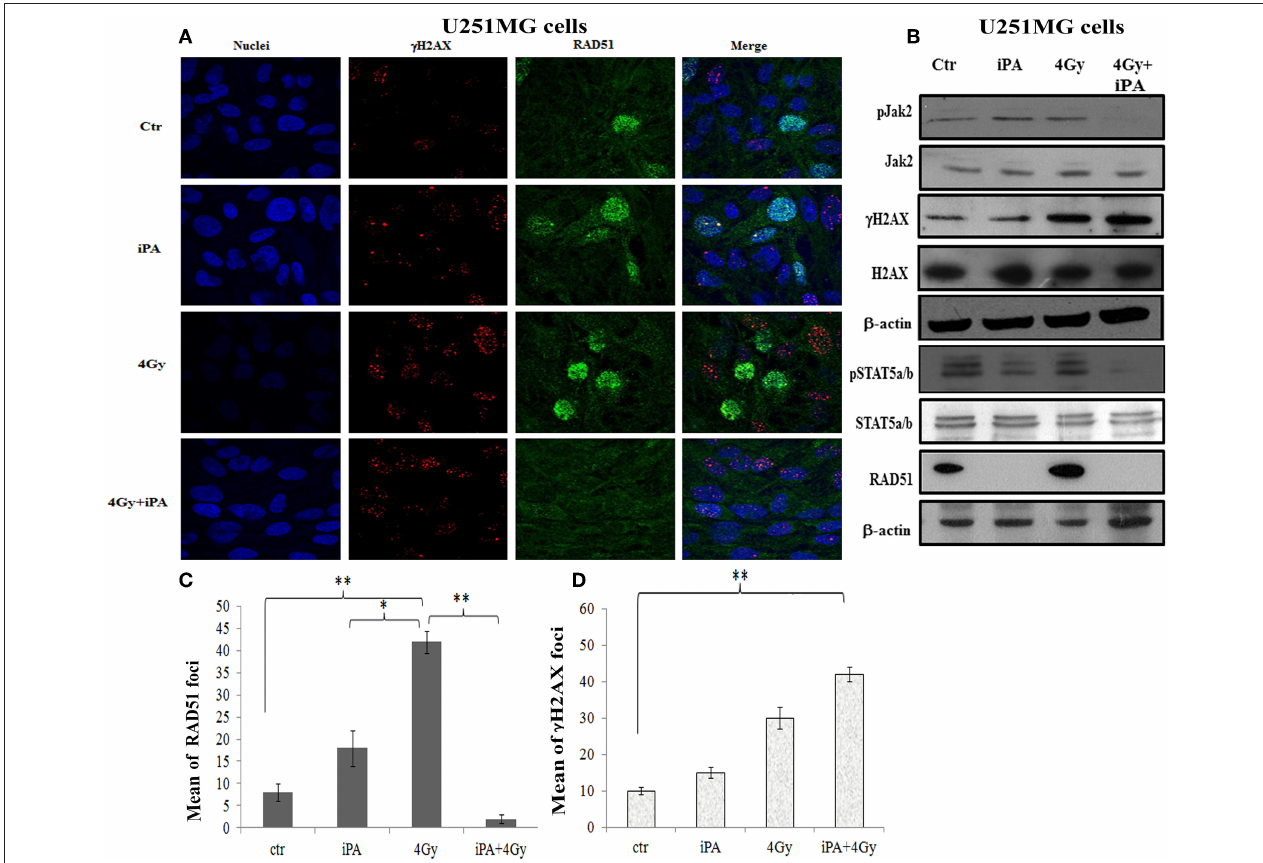
FIGURE 5 | iPA inhibited the RAD51 foci formation of U251MG cells. (A) Immunocytochemistry for phosphorylated γ H2AX (red), for RAD51 (green) in U251MG cells exposed to radiation in the presence of iPA and analyzed at 24h after irradiation. Hoechst 33258 used for nuclear staining (blue). (B) Whole cell extracts were collected for Western blot analysis using Jak2, Stat5a/b, RAD51, and γ -H2AX. β -actin was used as loading control. (C,D) Histograms represent quantification of RAD51 foci and γ H2AX foci in U251MG cells exposed to 4-Gy or the iPA/radiation combination. Values represent the means of 3 experiments ± SD; (ANOVA, * p < 0.05, ** p <